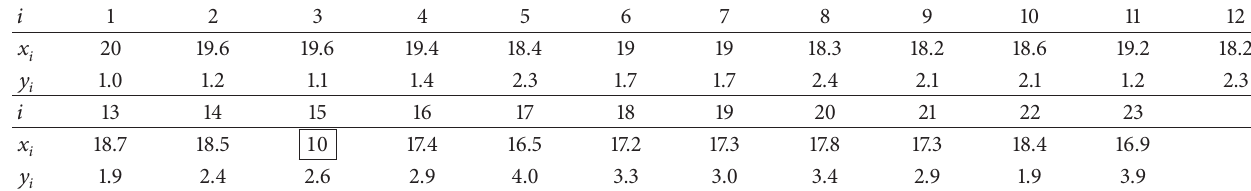
Table 2: Given data with outlier.